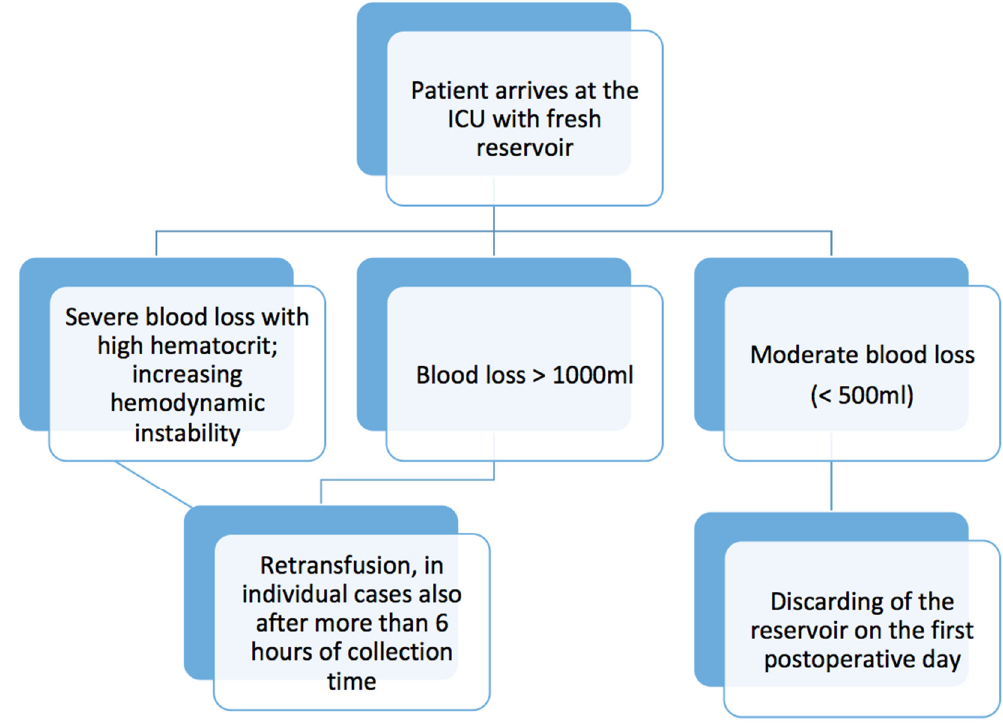
Figure 2. Flowchart for autotranfusion at the ICU .